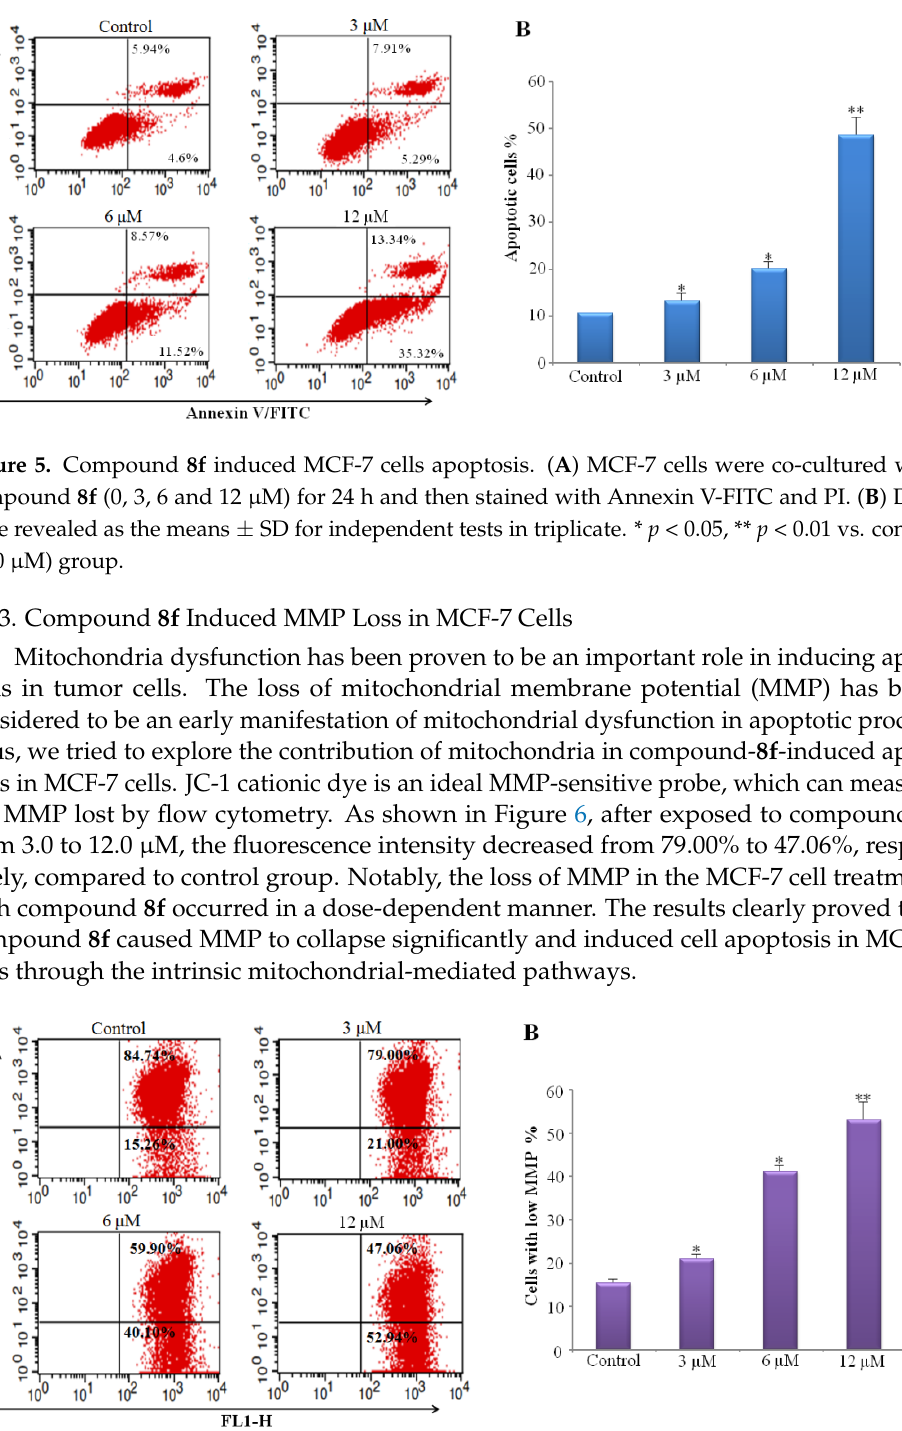
Figure 6. Compound 8f induced mitochondrial depolarization in MCF-7 cells. ( A ) MCF-7 cells were co-cultured with compound 8f (0, 3, 6 and 12 μ M) for 24 h and then stained with JC-1 cationic dye. ( B ) Data were revealed as the means ± SD for independent tests in triplicate. * p < 0.05, ** p < 0.01 vs. control ( 8f 0 μ M) group.